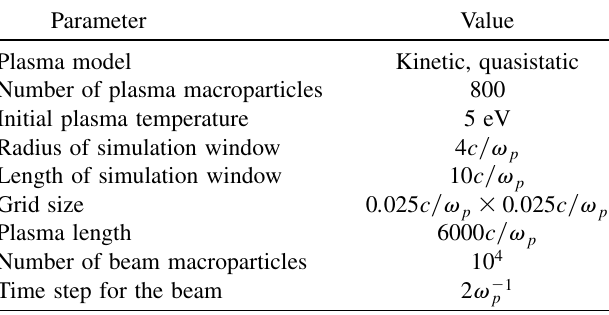
TABLE II. Adjustable parameters of the system. Parameter and notation